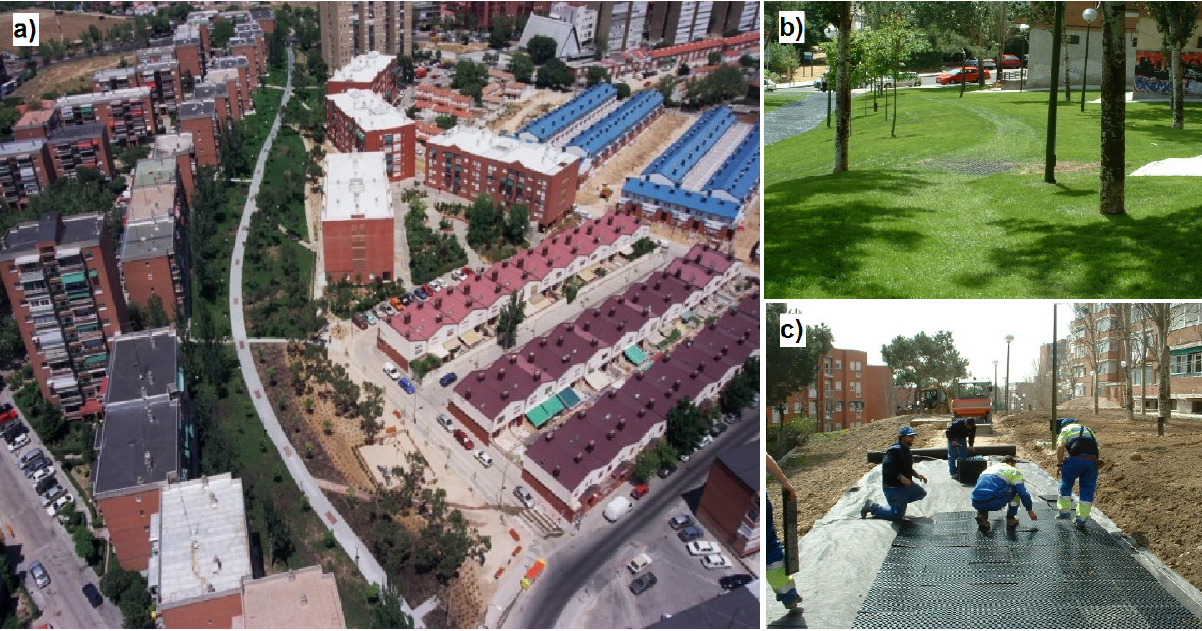
Figure 15. Gomeznarro Park [71]. (a) General view; (b) Finished pervious pavement; (c) Construction of pervious pavement.